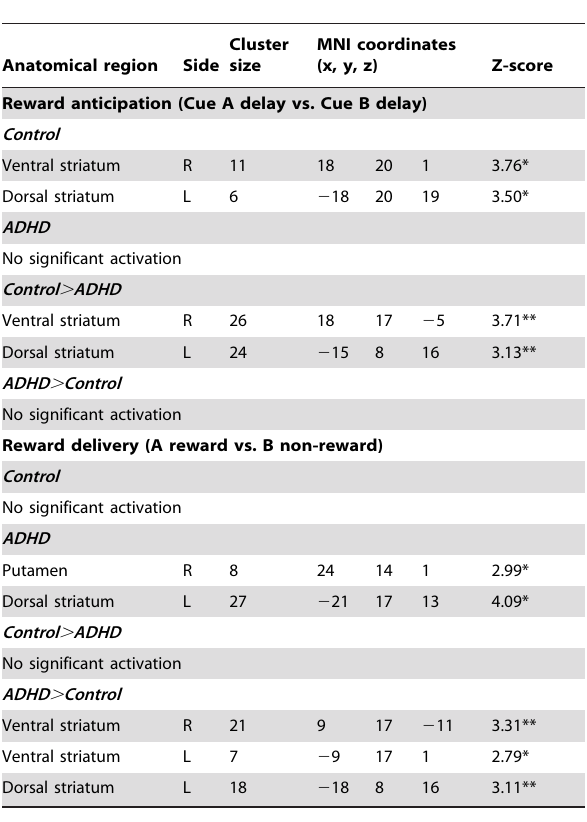
Table 1. BOLD responses to reward anticipation and reward delivery in the ADHD and control